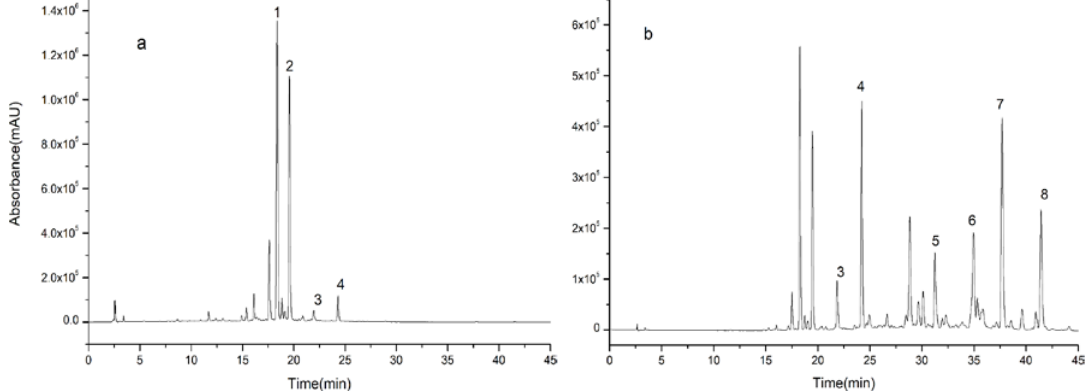
Figure 2. High performance liquid chromatography (HPLC) of ethanol elution of Aurantii fructus by the use of D101 macroporous resin, ( a ) 70% ethanol eluent and ( b ) 95% ethanol eluent.